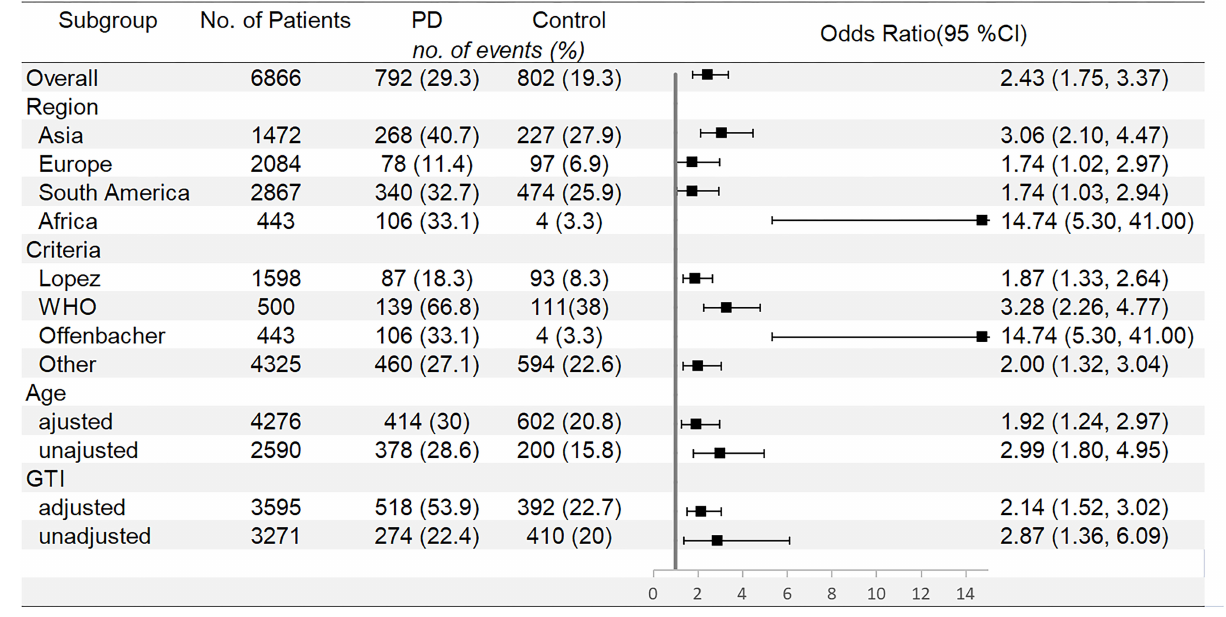
FIGURE 5 | Subgroup analyses for LBW.